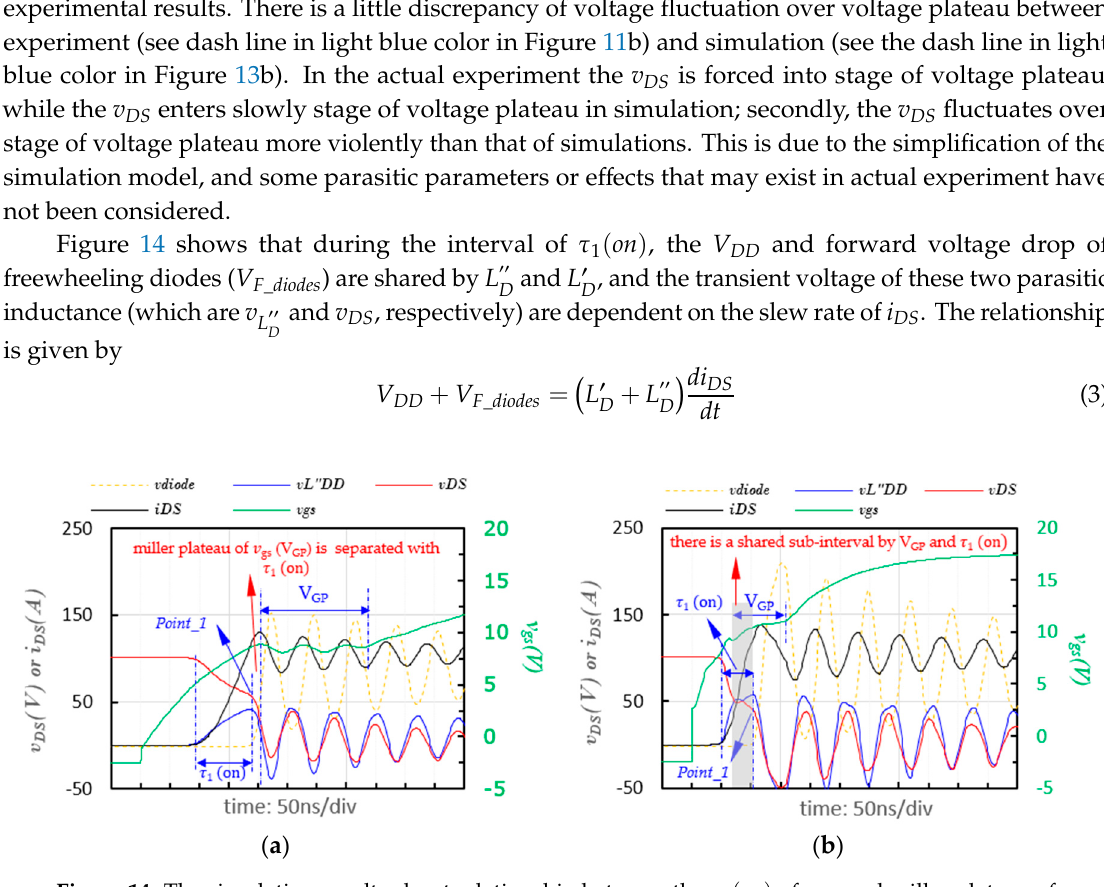
Figure 14. The simulation results about relationship between the 𝜏 (cid:2869) (𝑜𝑛) of 𝑣 (cid:3005)(cid:3020) and miller plateau v gs under 100 V / 100 A: ( a ) turn-on sped is slow ( R gext = 11 Ω ) , ( b ) turn-on speed is fast ( R gext = 2.4 Ω of 𝑣 (cid:3034)(cid:3046) under 100 V/100 A: ( a ) turn-on sped is slow ( 𝑅 (cid:3034)(cid:3032)(cid:3051)(cid:3047) = 11 Ω) , ( b ) turn-on speed is fast ( 𝑅 (cid:3034)(cid:3032)(cid:3051)(cid:3047) = 2.4 Ω ).